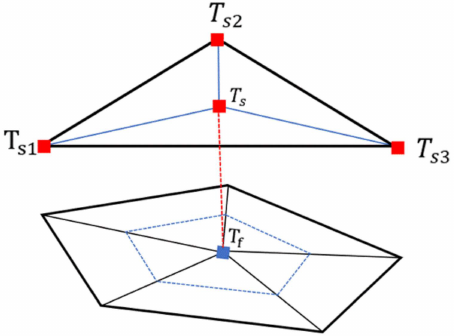
Figure 7. The thermal contact discretization method. From Figure 7, T s can be represented by the element nodal temperatures T = T s 1 T s 2 T s 3 T and its interpolation function N = N 1 N 2 N 3